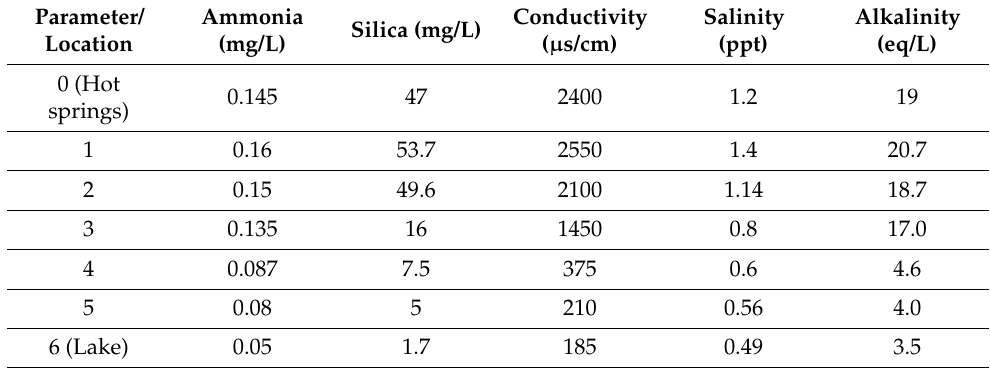
Table 1. The concentrations of chemicals at seven locations taken at the female site.